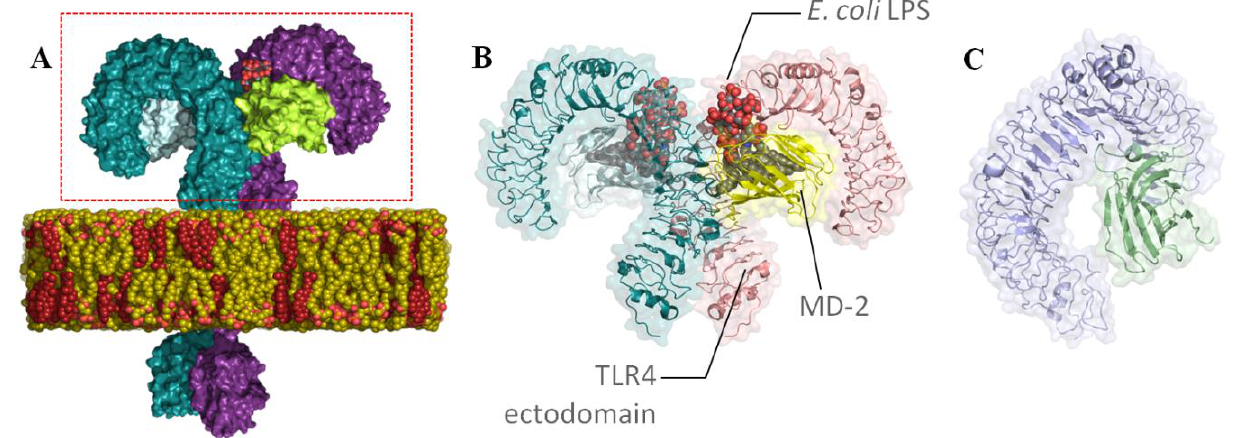
Figure 1. ( A ) Full-atom 3D model of the agonist LPS-bound TLR4 dimer in a membrane environ- ment [81]; ectodomain is framed in a red box. ( B ) X-ray structure of the TLR4/MD-2 dimer in complex with E. coli LPSs (from PDB ID 3FXI). ( C ) Three-dimensional model of TLR4/MD-2 in the antagonist conformation [66].